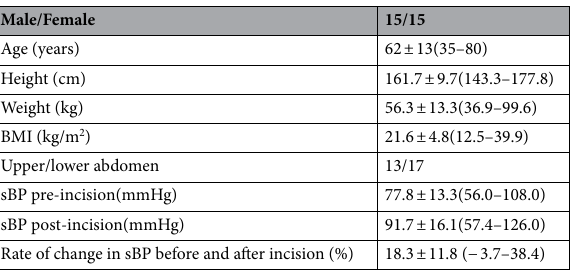
Table 1. Patient characteristics. Results are presented as mean ± SD (minimum–maximum). BMI body mass index, sBP systolic blood pressure.